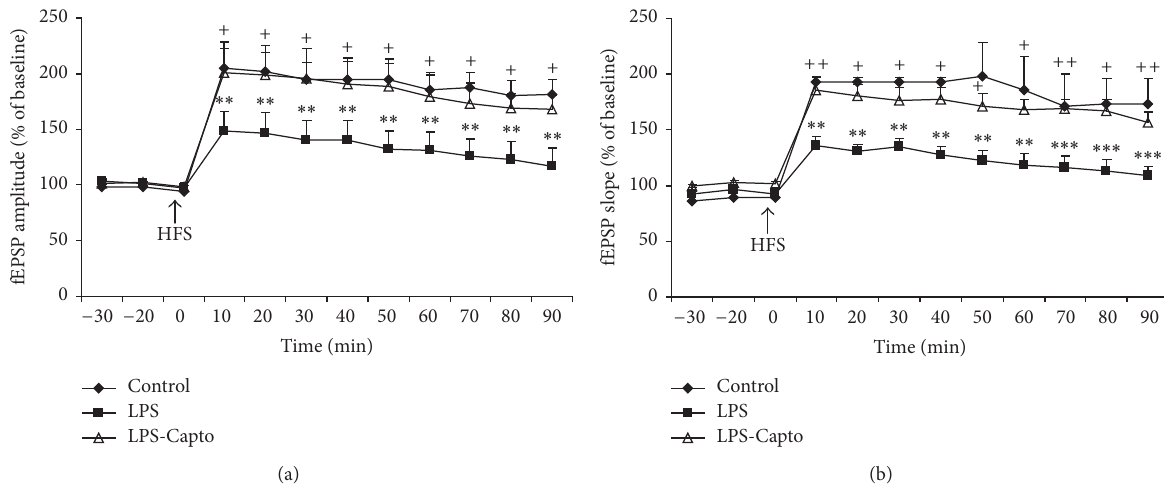
Figure 6: The results of LTP induction in CA1 area of the hippocampus using 100Hz tetanic stimulation at (a) the fEPSP amplitude and (b) the fEPSP slope. Data are presented as the average percentage changes from baseline responses. Each point shows mean ± SEM ( 𝑛 = 8 in each group). The amplitude and slope of fEPSP in the LPS group were lower than those in the control group ( ∗∗ 𝑃 < 0.01 and ∗∗∗ 𝑃 < 0.001 ) and in the LPS-Capto group they were higher with respect to the LPS group ( + 𝑃 < 0.05 and ++ 𝑃 < 0.01